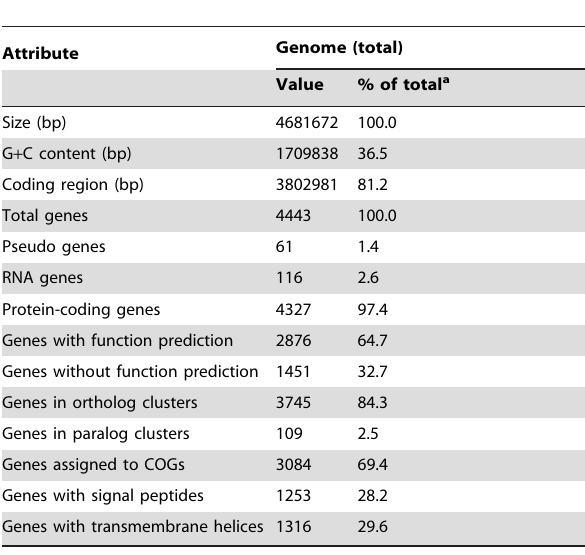
Table 1. Nucleotide content and gene count levels of the Bcell